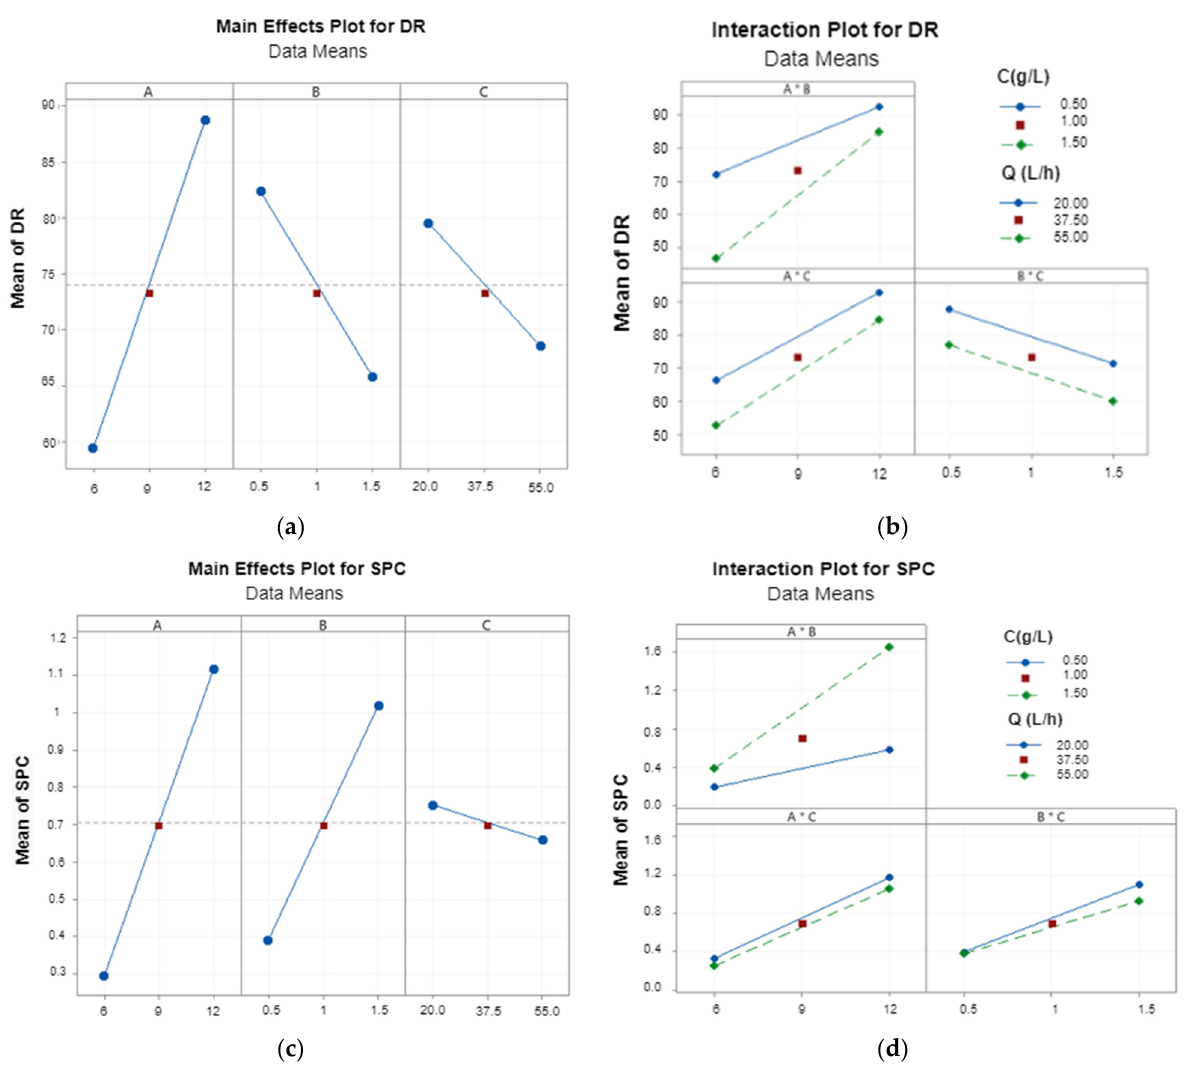
Figure 3. The factorial design plots of demineralization rate (DR) and specific power consumption (SPC) as a function of 3 factors A = E (V); B = C (g·L − 1 ); C = Q (L·h − 1 ): ( a ) main effects plots of response (SPC) as a function of 3 factors A = E (V); B = C (g · L − 1 ); C = Q (L · h − 1 ): ( a ) main effects plots of of DR and ( c ) SPC; ( b ) interaction plots of response of DR and ( d ) SPC. response of DR and ( c ) SPC; ( b ) interaction plots of response of DR and ( d )